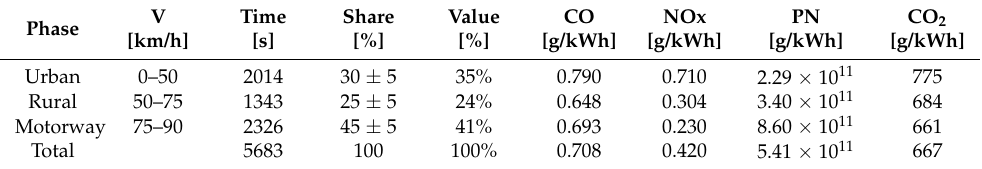
Figure 17. Two-dimensional distribution of flow intensity of CO 2 ( a ), CO ( b ), NO x ( c ) and PN ( d ) in the speed–acceleration coordinates in N3 category vehicle. Table 4. Results of tests of road emissions from N3 category heavy-duty